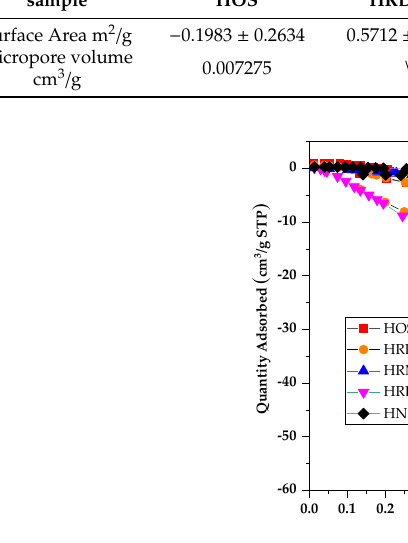
Figure 8. N 2 adsorption-desorption isotherms of different fractions. Table 7. Physical properties of different fractions